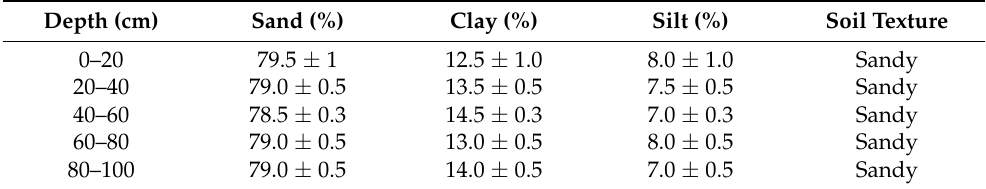
Table 3. Soil texture in each depth of perimeters P 1 and P 2 . Depth (cm)